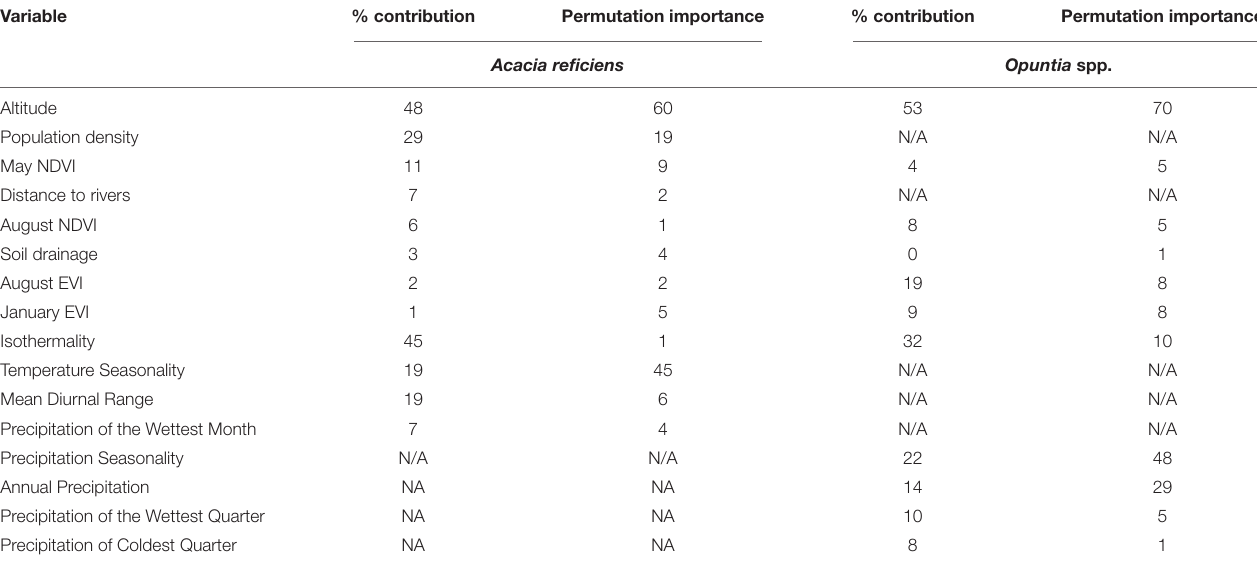
TABLE 1 | Permutation and percent importance of remote sensing and topo-climatic predictor variables of the two MaxEnt models for A. reficiens and Opuntia spp. under the current and potential distribution. Variable %